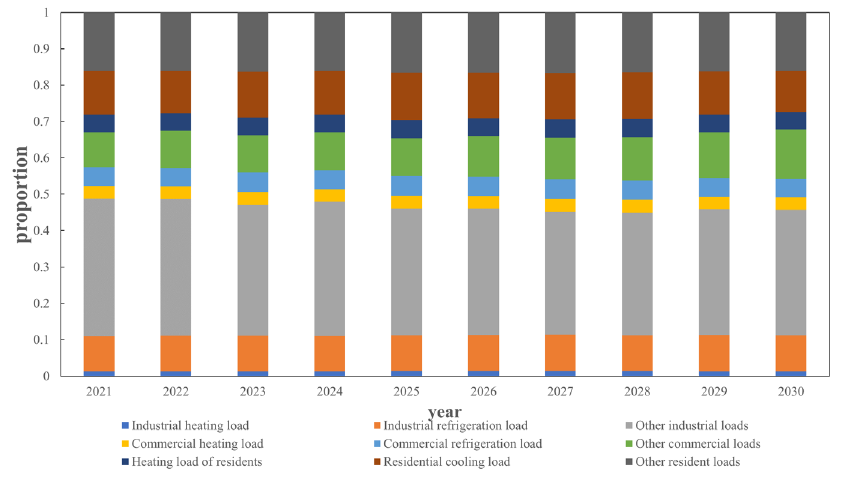
Figure 15. Node 1 load proportion prediction.